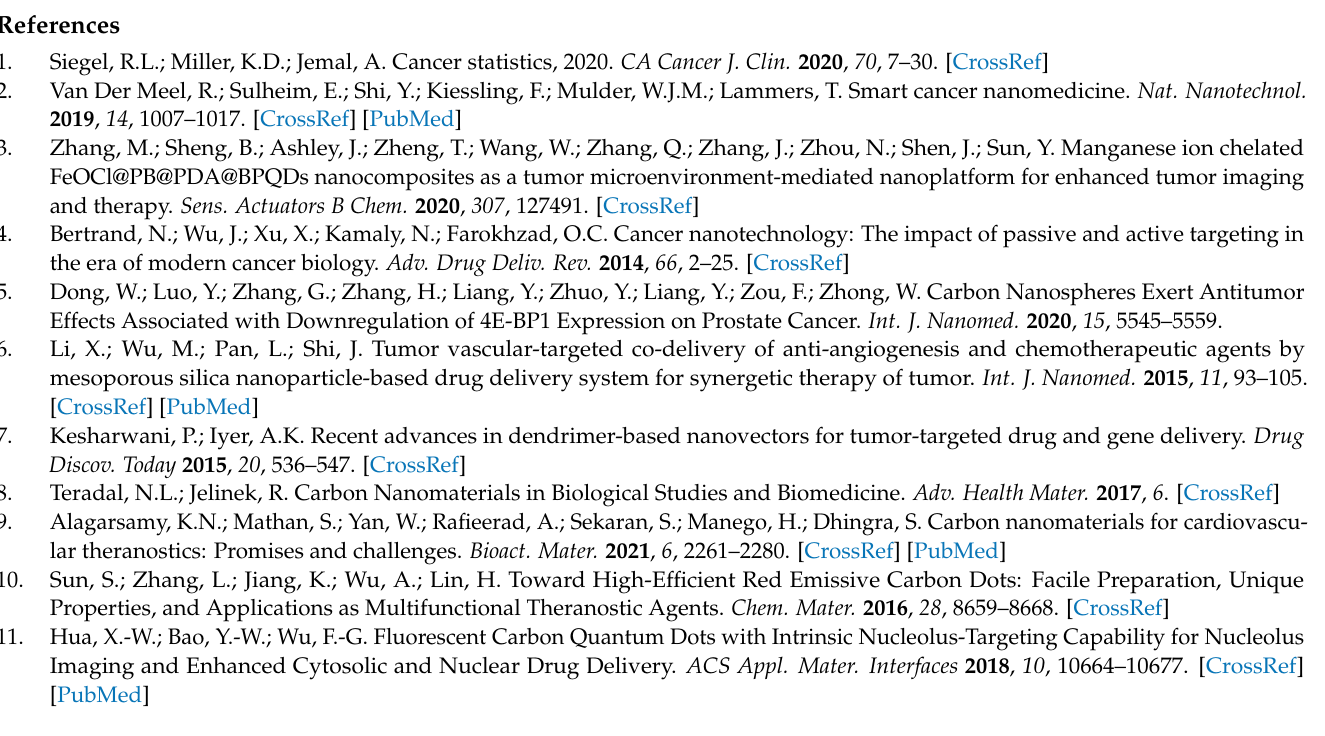
MRI scanning, Figure S6: Weekly evaluations by MRI of each tumor-bearing animal treated with Gadovist, Figure S7: Weekly evaluations by MRI of each tumor-bearing animal treated with Mn-CDs- NHF, Figure S8: In vivo tissue distribution of Mn-CDs-NHF, Figure S9: Quantification of MRI signal intensity in primary